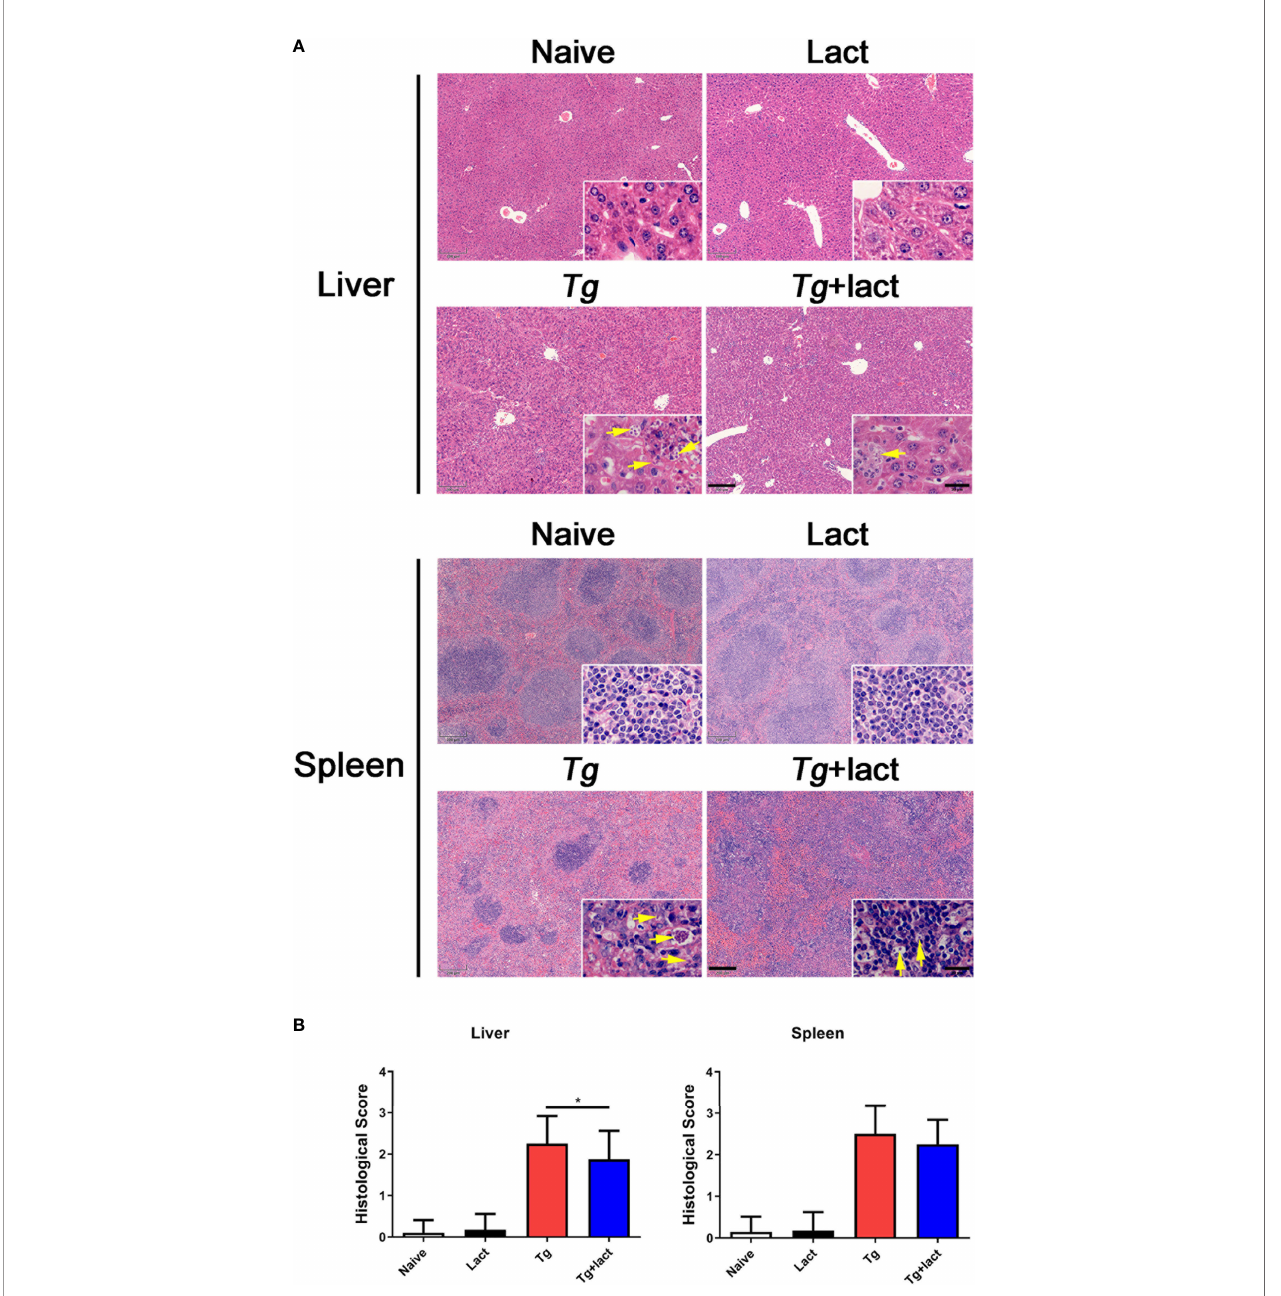
FIGURE 2 | The liver and spleen histopathology of mice from different groups. Mice were i.p. inoculated with 10 2 tachyzoites of T. gondii and killed at day 7 p.i. (A) Representative microscopic pictures showed tissue sections stained with H&E from different groups. Original magni fi cation 50× (scale bar = 200 µm) of the large image; the small image is 1000× (scale bar = 20 m m). Yellow arrows indicate T. gondii tachyzoites. (B) Histopathological score analysis of the liver and spleen tissues. Data are represented as mean ± SD. There were 4 mice per group, and the data are representative of two experiments. * P <